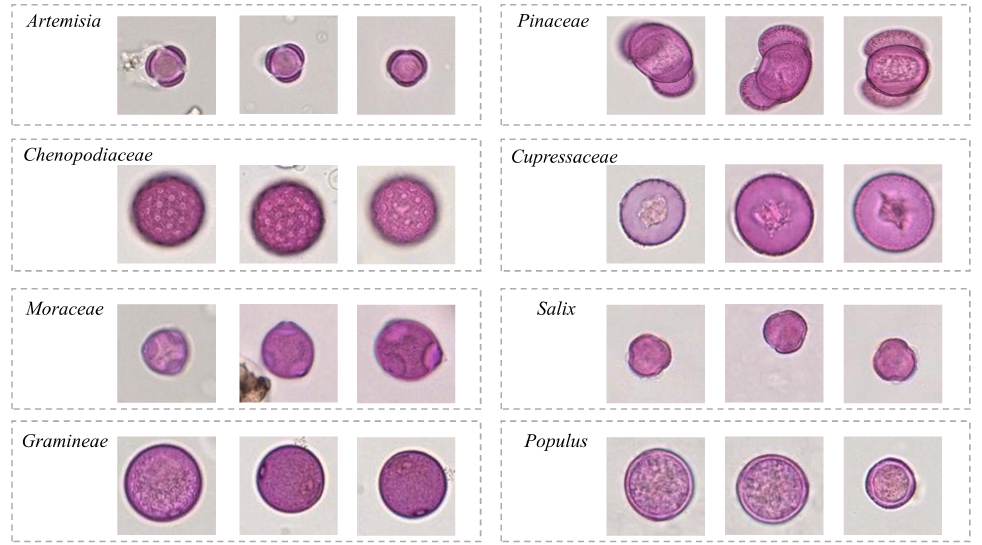
Figure 3. Some examples of each allergic pollen